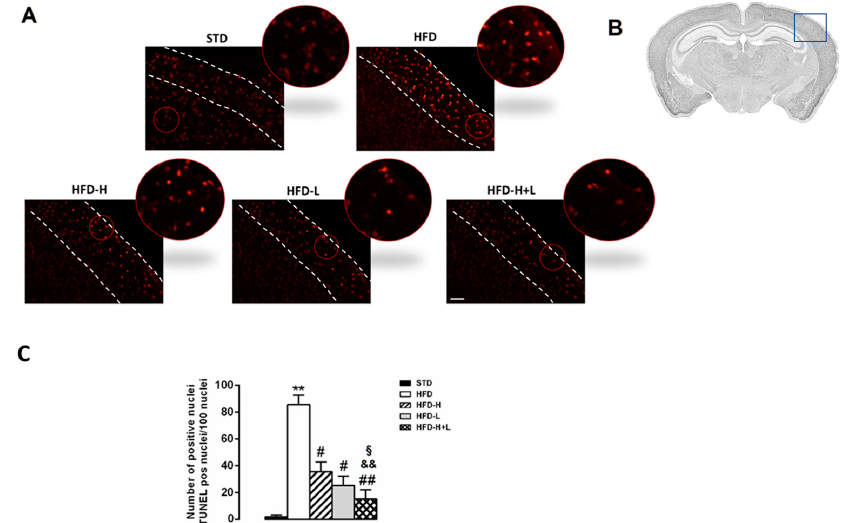
Figure 2. Neurodegeneration. ( A ) TUNEL assay; the outlined area is enlarged in the circle; white dotted lines represent the mouse brain cortex. ( B ) Schematic representation of cerebral cortex of positive areas. ( C ) Number of apoptotic nuclei in cerebral cortex of STD, HFD, HFD-H, HFD-L and HFD-H + L mice. Data are mean values ± S.E.M. (n = 8/group). ** p < 0.01 vs. STD mice; # p < 0.05, ## p < 0.01 vs. HFD mice; && p < 0.01 vs. HFD-H mice; § p < 0.05 vs. HFD-L mice. Microscope magnification 10 × . Scale bar, 200 µ m.